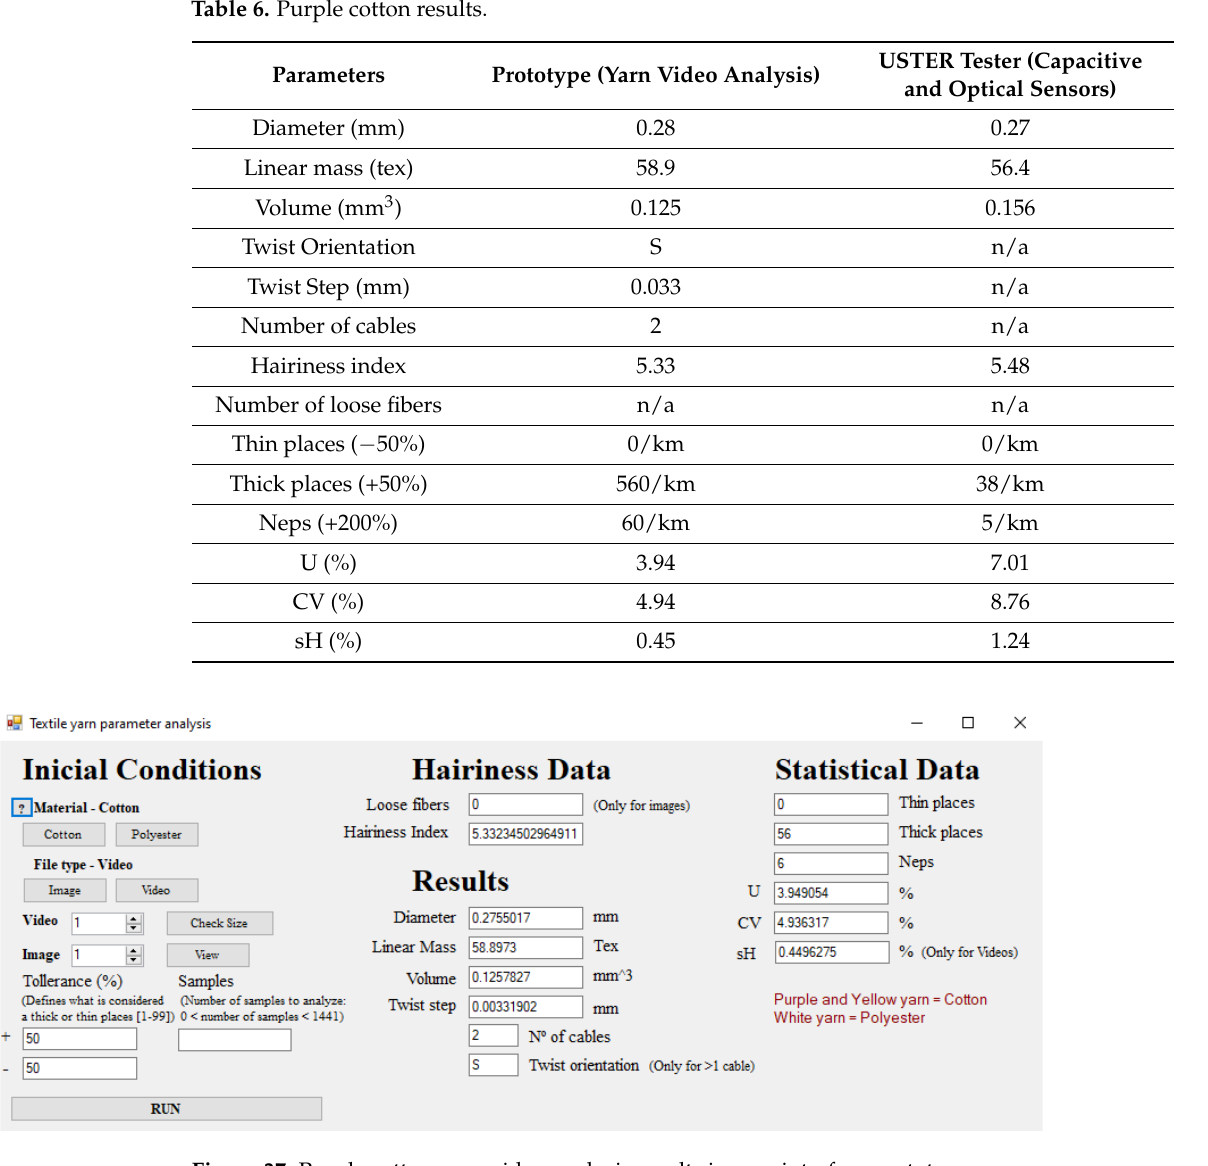
Figure 37. Purple cotton yarn video analysis results in user interface prototype.